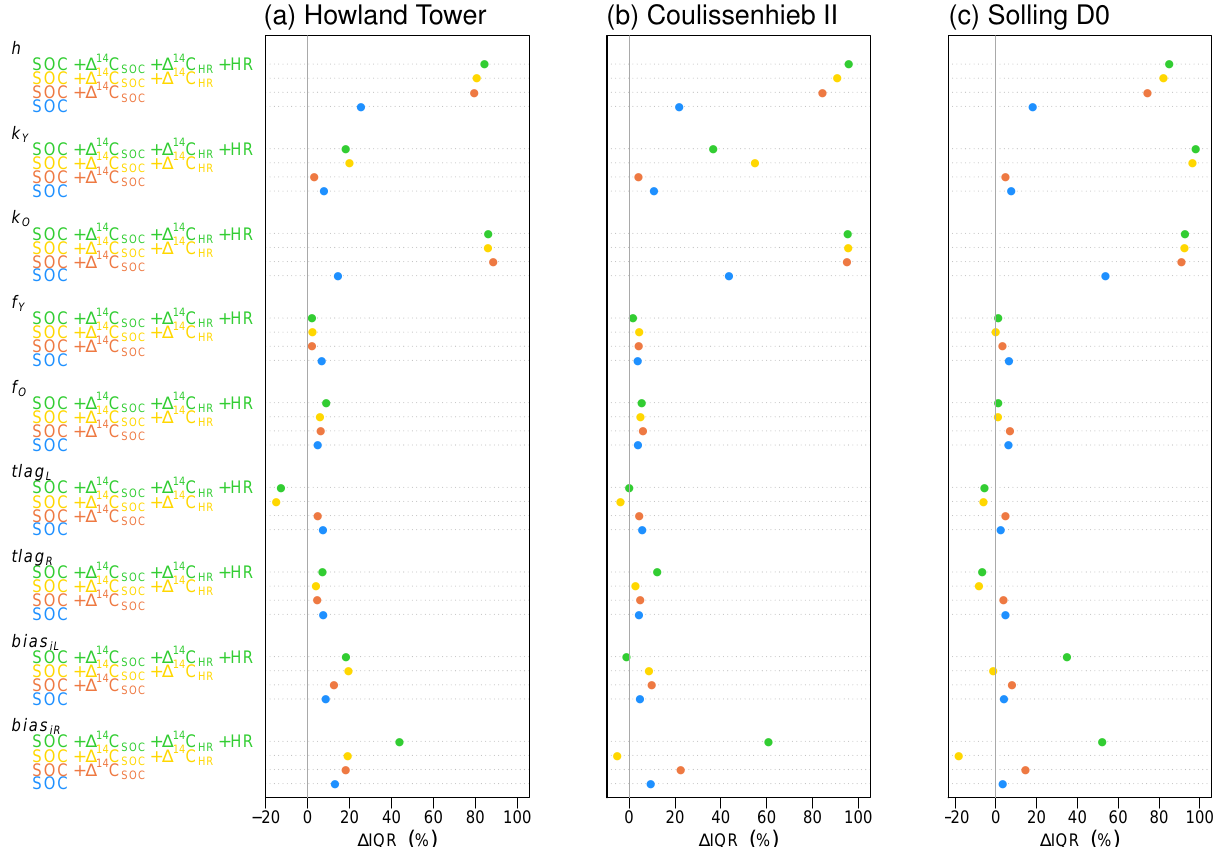
Fig. 3. Change of interquartile ranges, 1 IQR, between prior and posterior marginal distributions of the different model parameters at all three sites for the four multiple constraints calibration